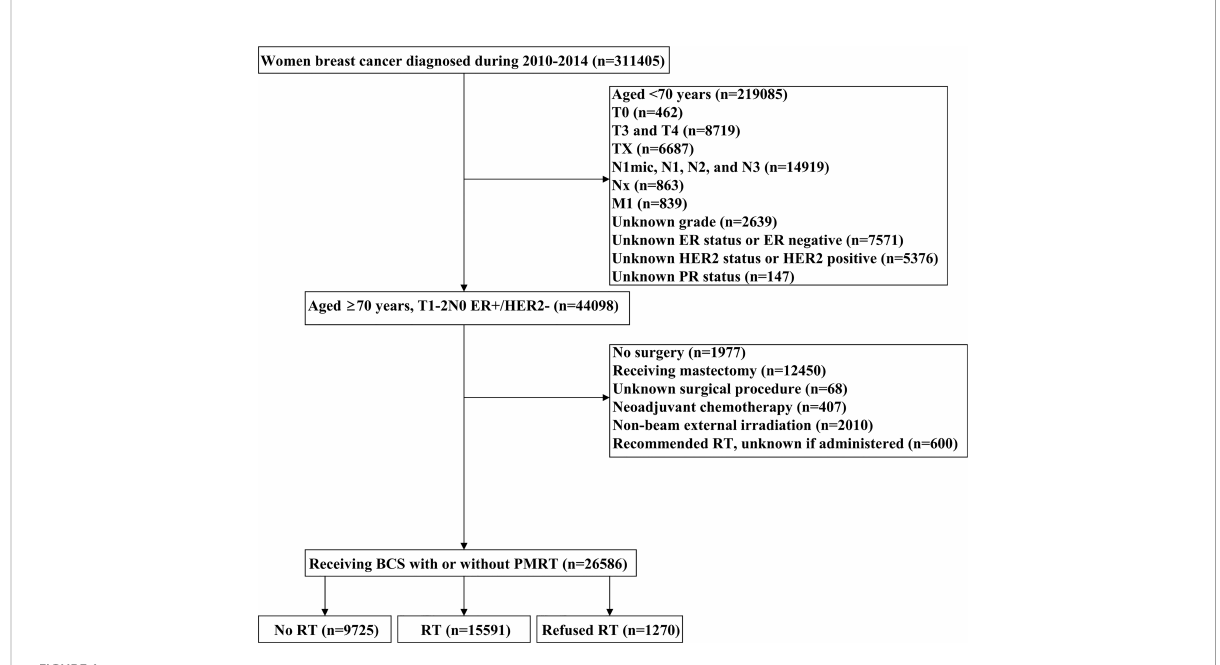
FIGURE 1 Flow diagram of the study